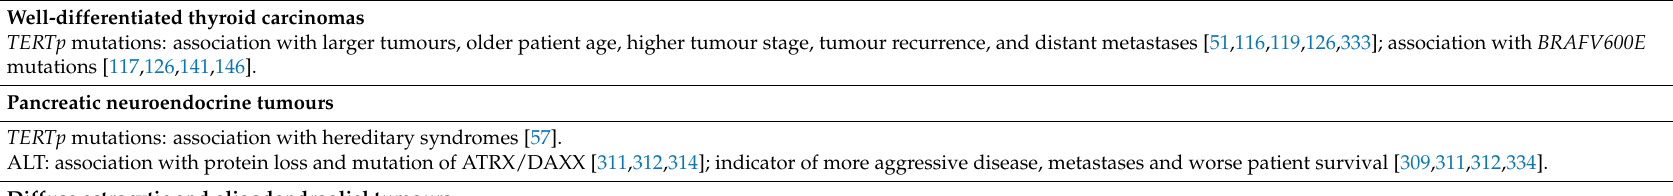
Table 5. Molecular associations, prognostic and clinical implications of telomere maintenance mechanisms in human tumours. Hepatocellular Carcinomas TERTp mutations: marker of malignant progression [95,331,332]. Well-differentiated thyroid carcinomas TERTp mutations: association with larger tumours, older patient age, higher tumour stage, tumour recurrence, and distant metastases [51,116,119,126,333]; association with BRAFV600E mutations